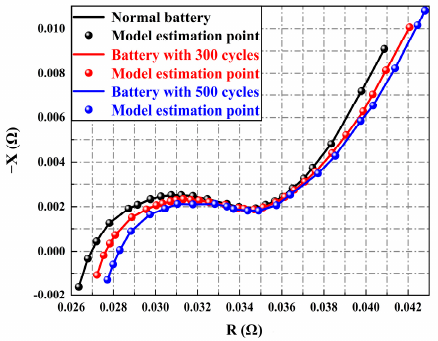
Table 1. Battery capacity and SOH values for the three cycle states.